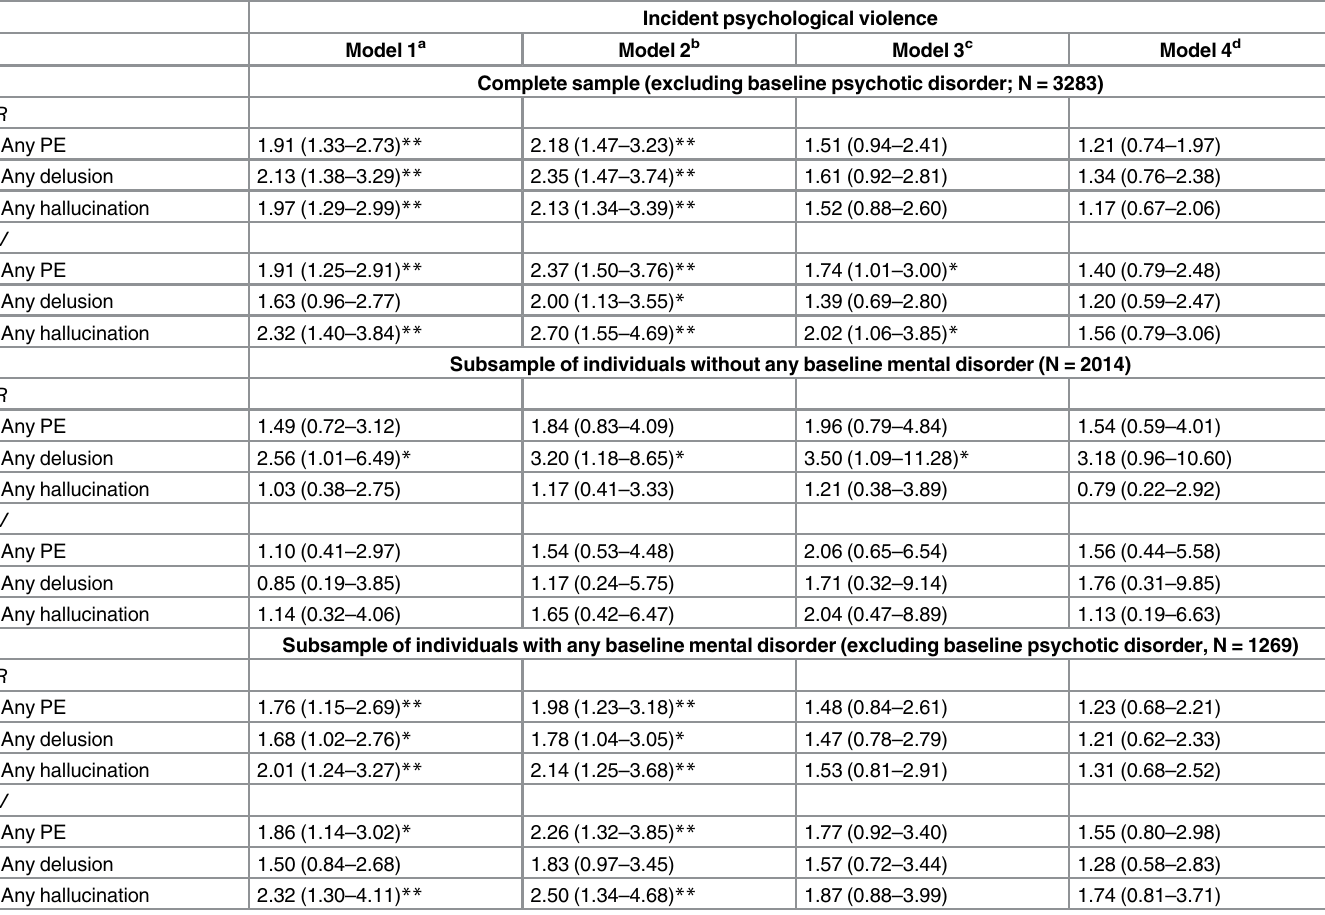
Table 3. Results (odds ratios and 95% CI) from logistic regression analyses on the association between self-reported (SR) and clinically validated (CV) psychotic experiences and six-year incidence of psychological violence in a general population sample and two